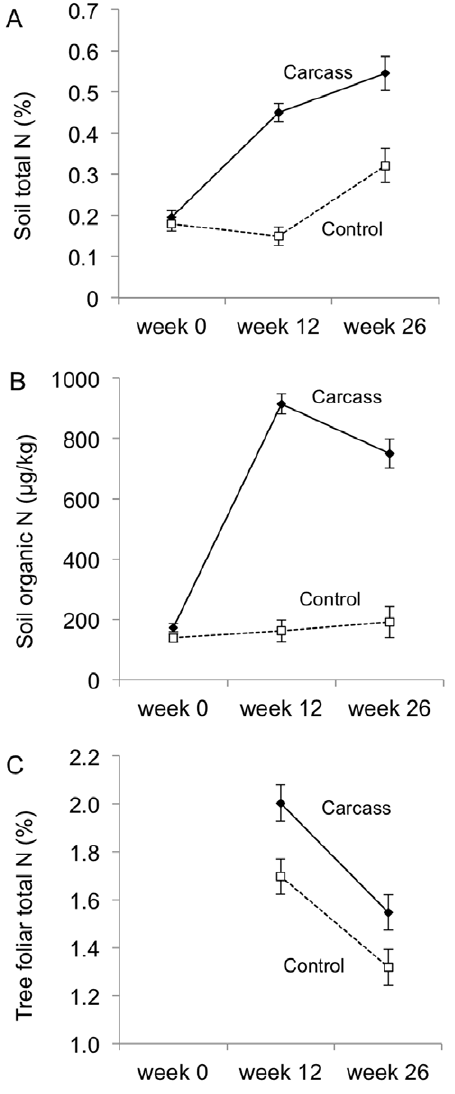
Figure 1. Effect of carrion on soil and foliar nitrogen. Carrion increased (a) soil total nitrogen, (b) soil organic nitrogen, and (c) tree foliar total nitrogen relative to control sites. Error bars show mean 6 SE.